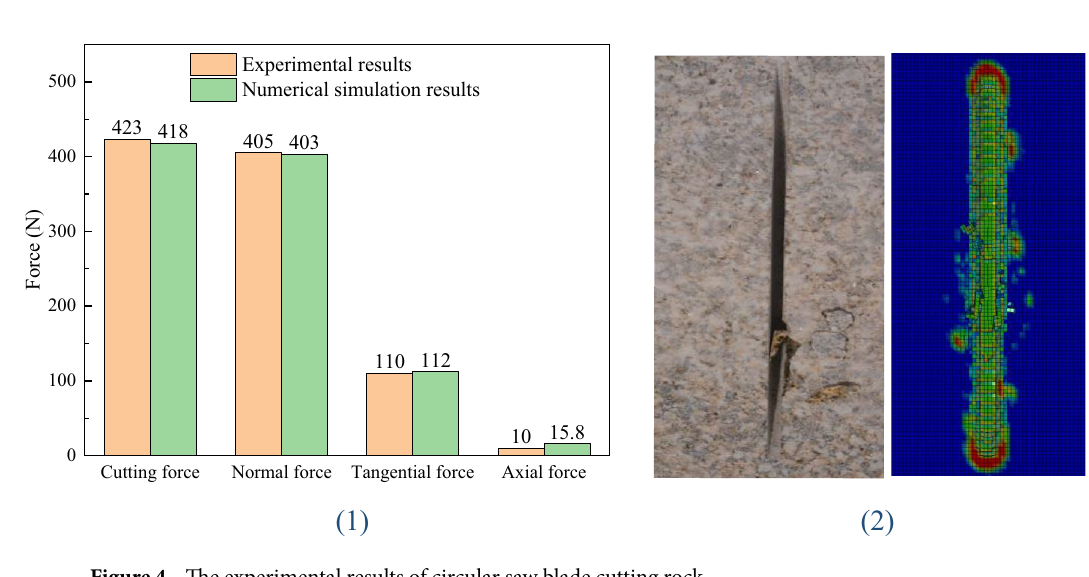
Figure 3. The circular saw blade cutting rock test bench.